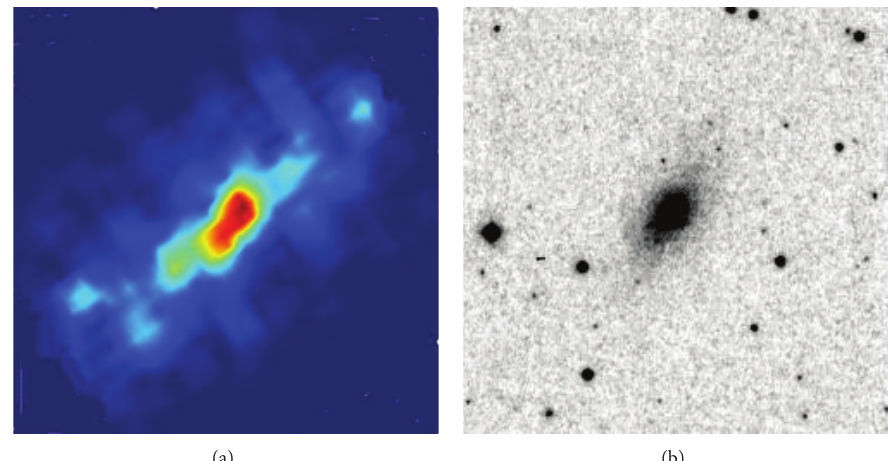
Figure 4: Morphology of UGC 7639. (a) r-band luminosity density map from our simulation at the best-fitting snapshot (see text), on the same scale as the observed one. (b) 7 󸀠 × 7 󸀠 r-band image (dss1). (a) is normalized to its total flux.